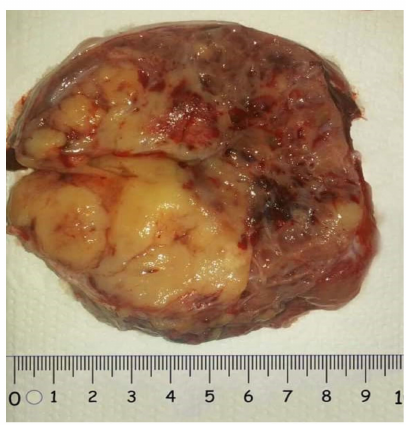
Figure 8. Yolk sac tumor (courtesy of Prof. G.